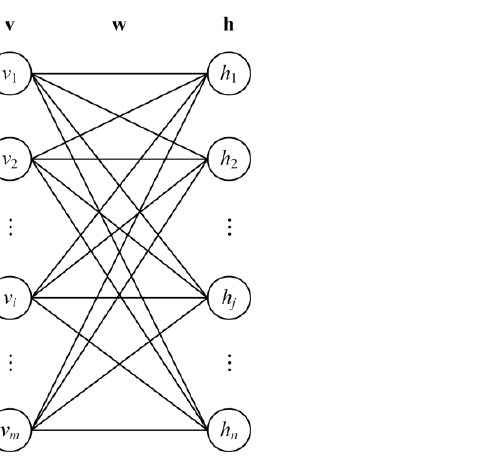
Figure 2. Schematic diagram of restricted Boltzmann machine